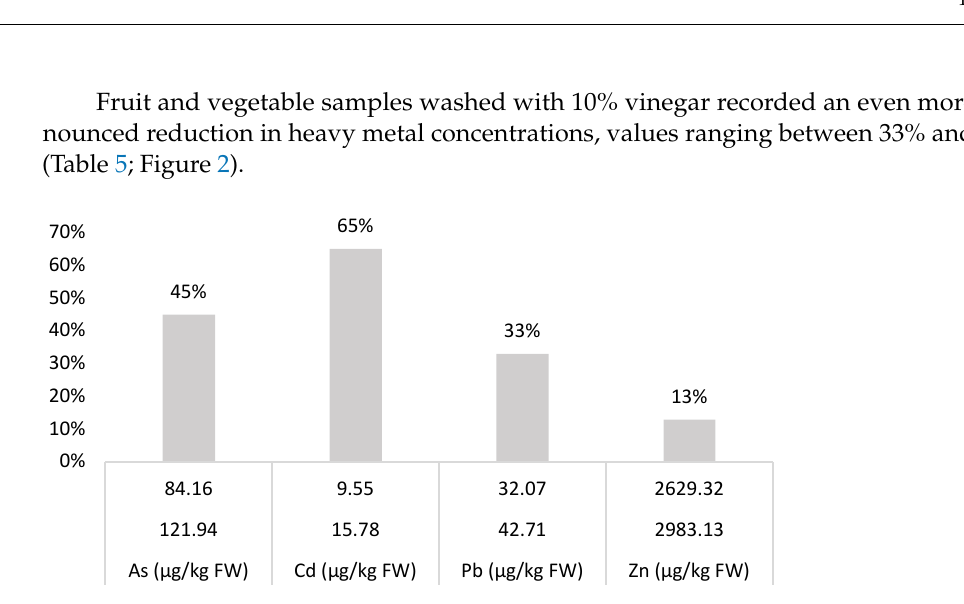
Table 5. The concentration of heavy metals analyzed in samples of fruit and vegetables washed with tap water and vinegar (10% acetic acid).